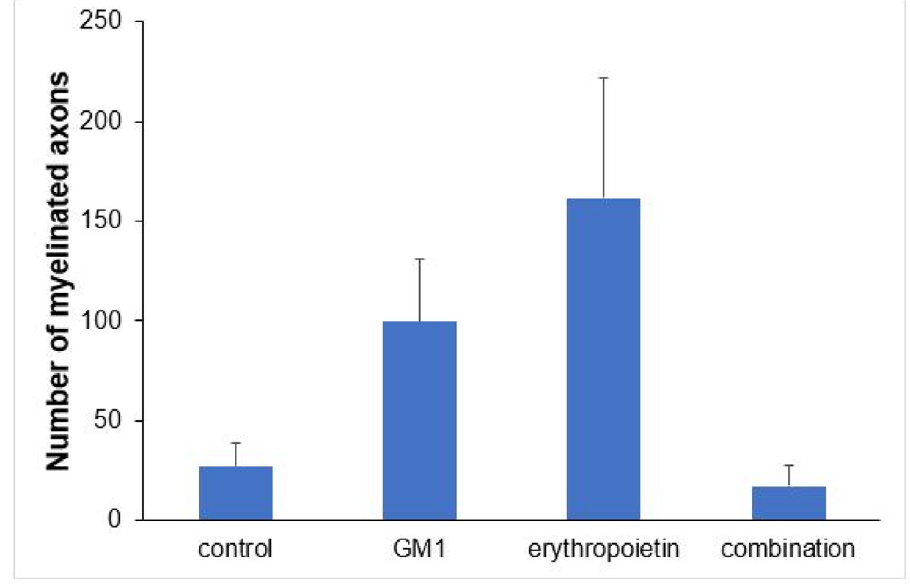
Fig. 4. Mean values and respective standard errors of the number of axons per